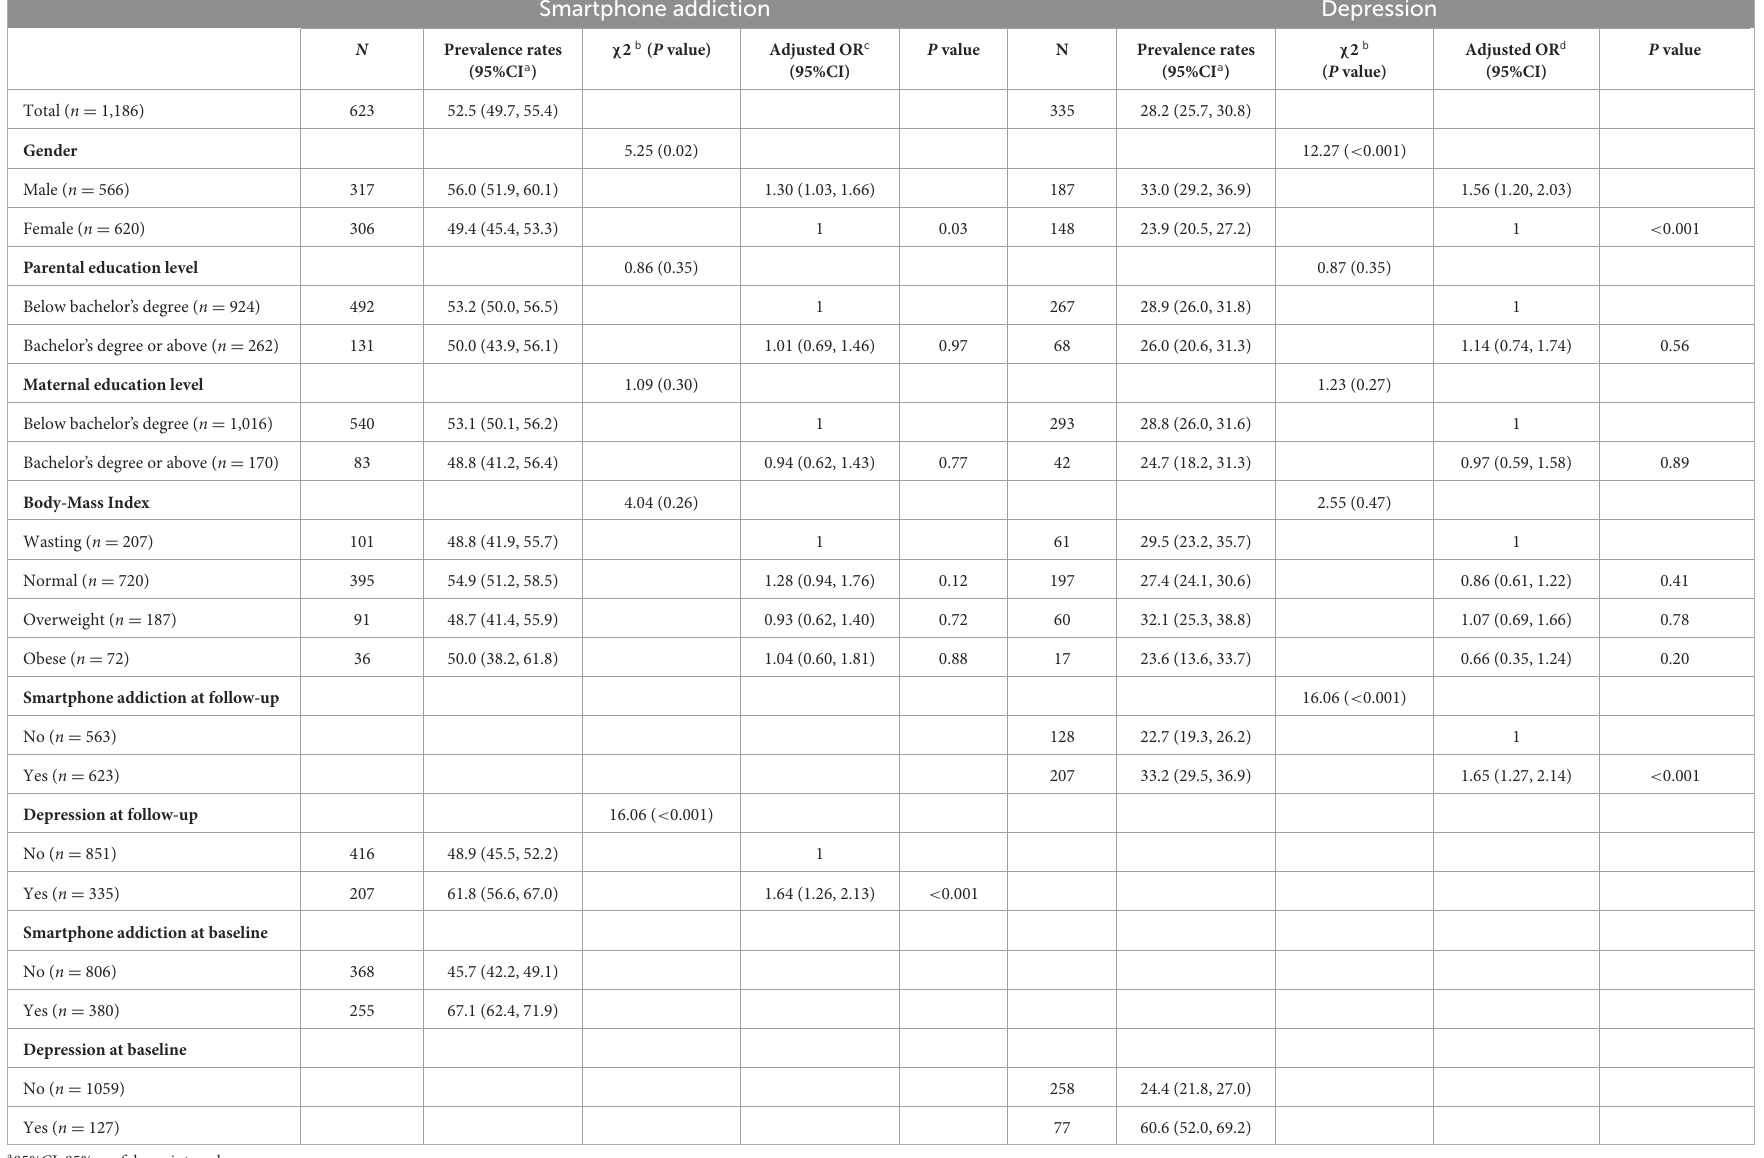
TABLE 3 The detection rates and predictors for smartphone addiction and depression in the following among respondents who responded to both surveys. Smartphone